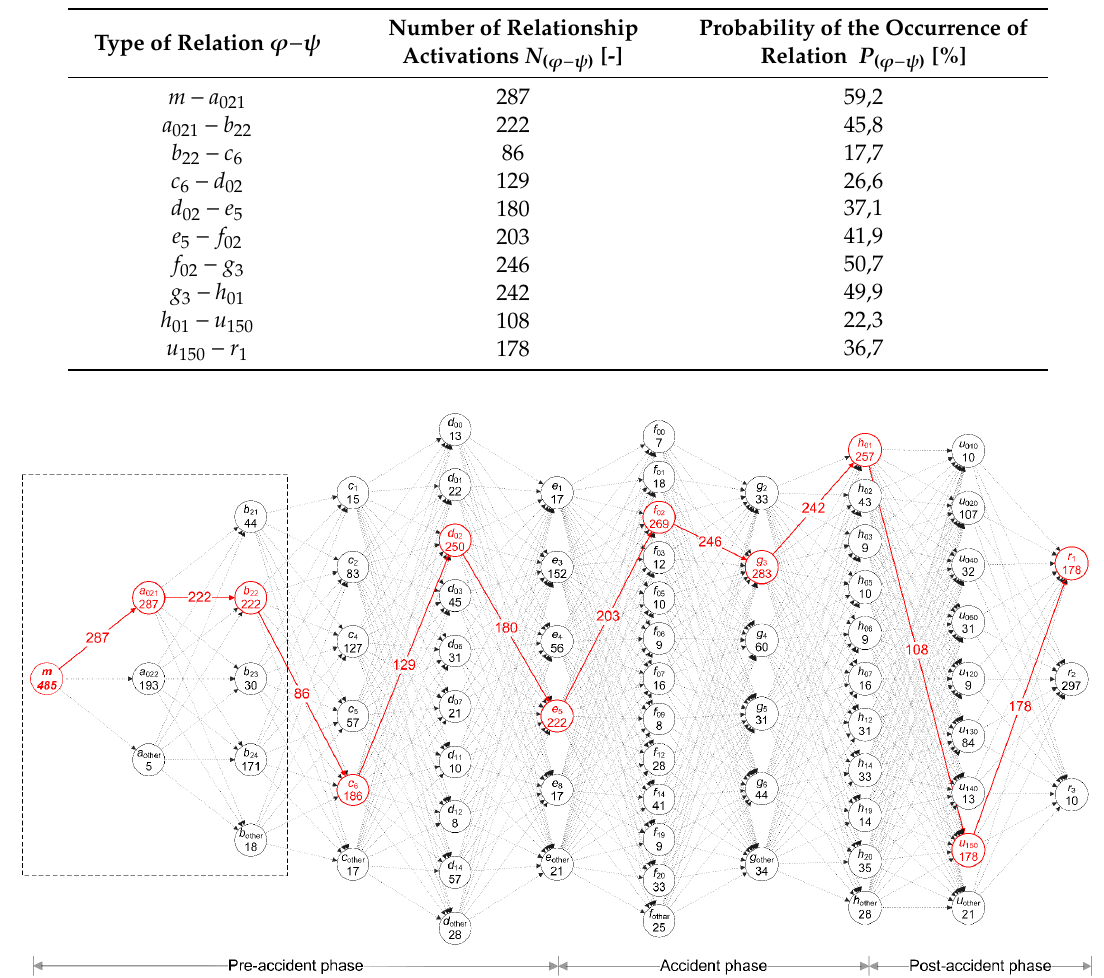
Figure 5. Critical path defined for the set of 485 analyzed accidents (own elaboration).